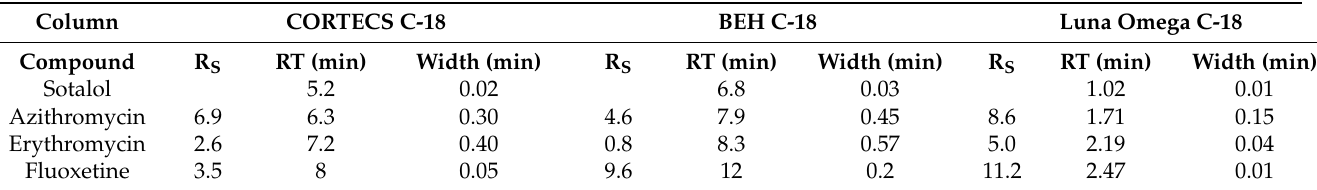
Table A1. Comparison of individual column tested.